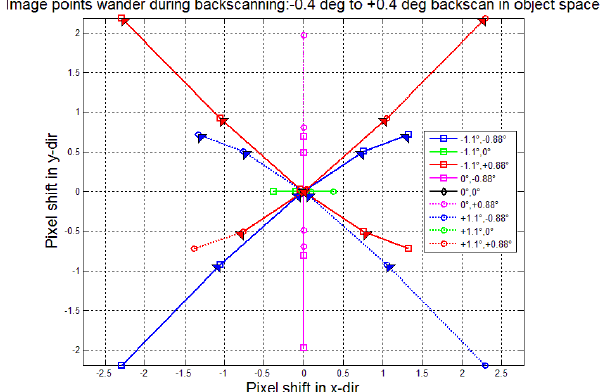
Figure 12. Image points wander during back-scanning under field mapping condition h = f (cid:48) θ : − 0.4 deg to + 0.4 deg back-scan in object space.